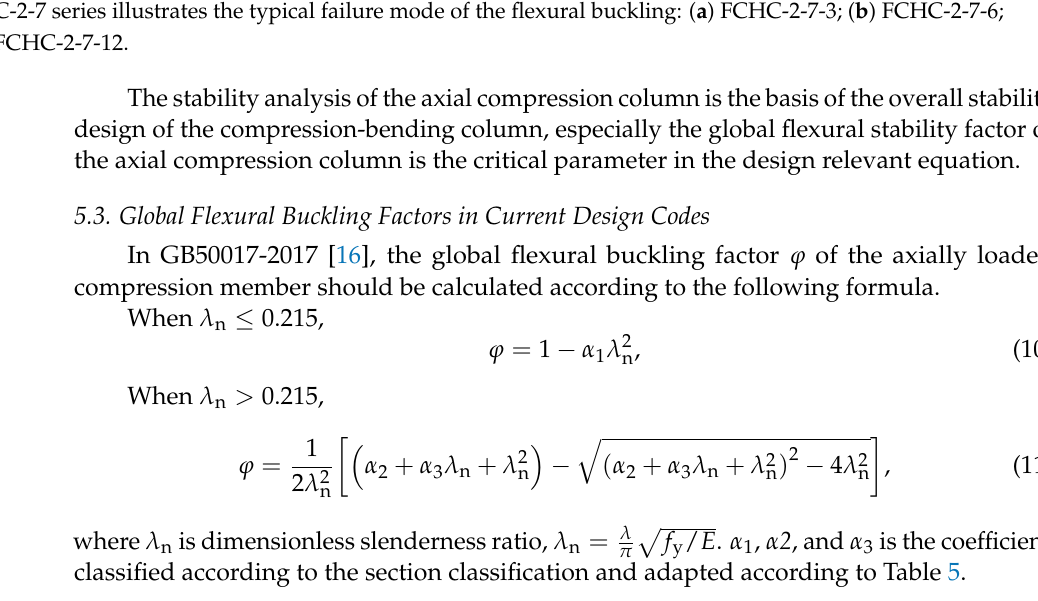
Figure 10. The FCHC-2-7 series illustrates the typical failure mode of the flexural buckling: ( a ) FCHC-2-7-3; ( b ) FCHC-2-7-6; ( c ) FCHC-2-7-9; ( d ) FCHC-2-7-12.